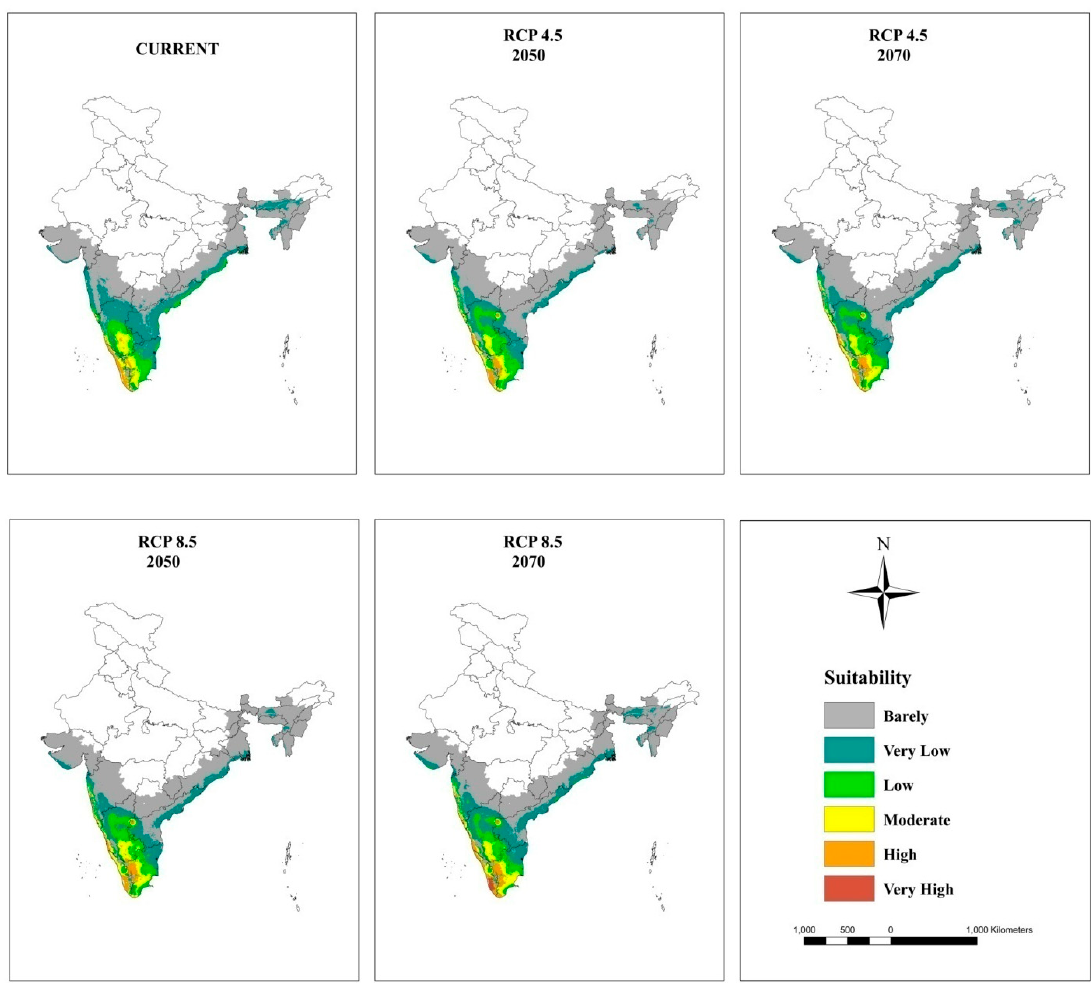
Figure 5. Climatically suitable areas for coconut production in India under the current and future climates of the 2050s and 2070s for RCP 4.5 and RCP 8.5 as modeled by MaxEnt.